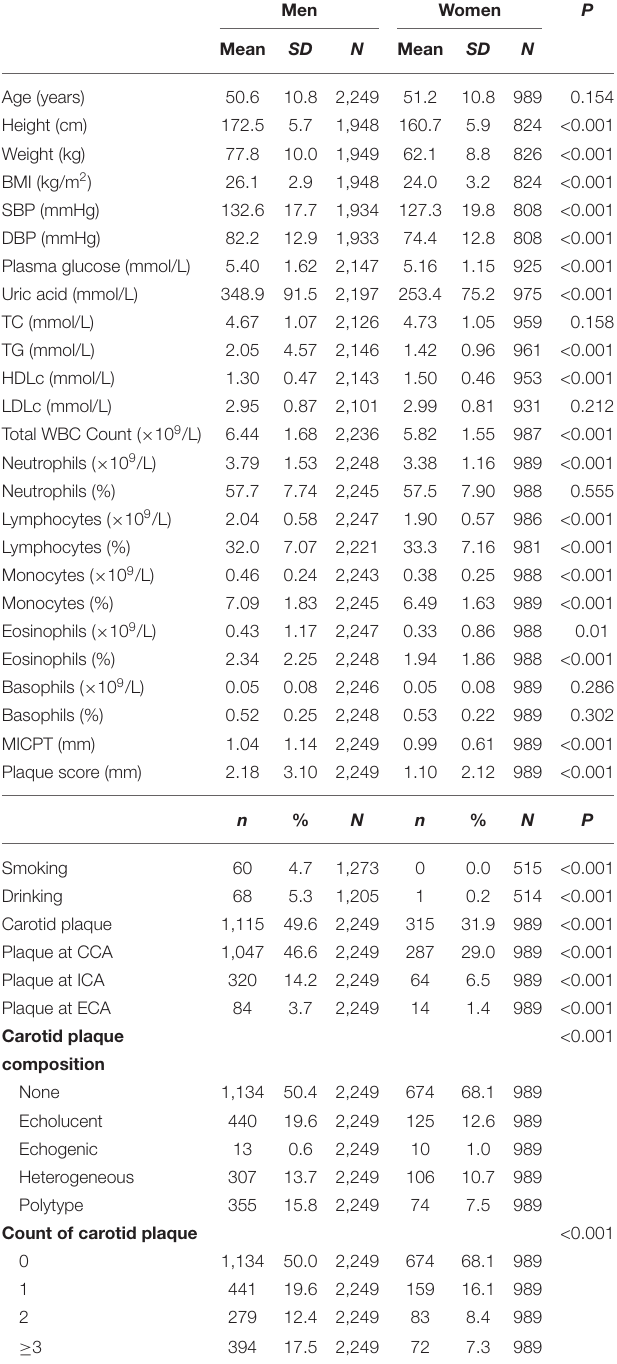
TABLE 1 | Characteristics of the study